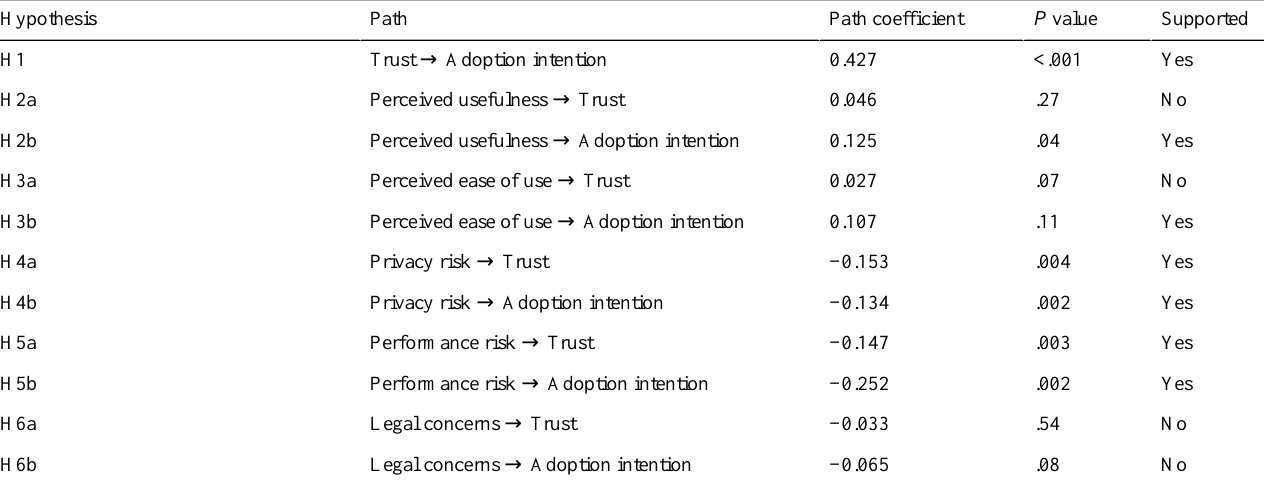
Table 7. Results of the hypothesis testing.